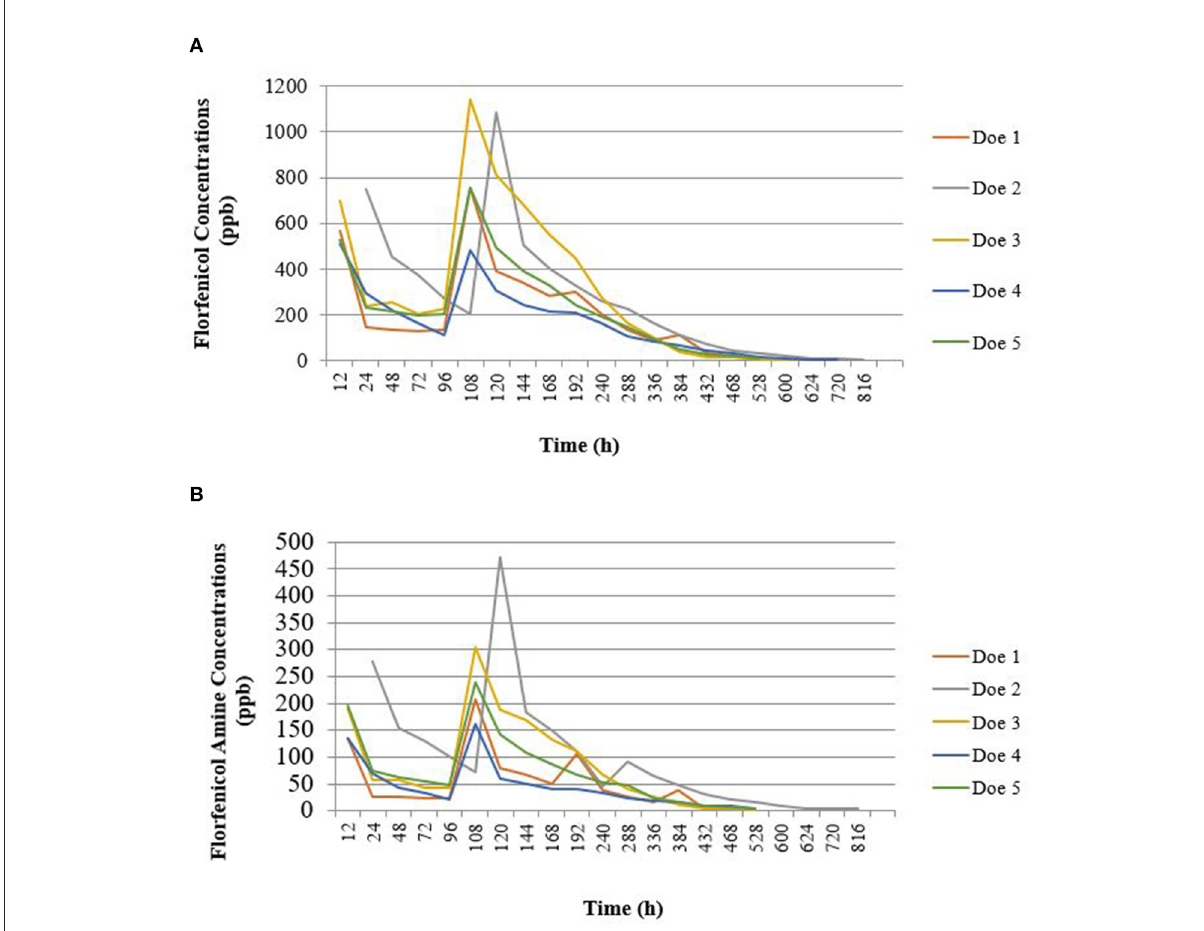
FIGURE3 Goat milk sample florfenicol (A) and florfenicol amine (B) concentration vs. time profile. Florfenicol was administered subcutaneously at a dose of 40 mg/kg twice 4 days apart in lactating does ( n = 5). Florfenicol and florfenicol amine were quantified using ultra-performance liquid chromatography with tandem mass